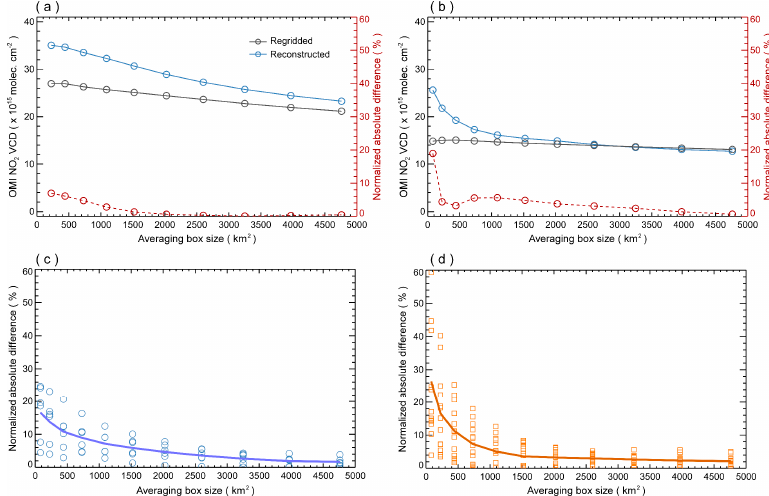
Figure 10. A comparison of the re-gridded and reconstructed OMI NO 2 VCD in terms of an averaging box size for (a) Seoul metropolitan area and (b) a site with cement industrial facilities in South Korea. The normalized absolute difference of the reconstructed OMI NO 2 VCD is given for (c) 6 urbanized area sources and (d) 13 isolated point sources. Solid lines in (c) and (d) represent the mean normalized absolute difference for the urbanized area sources and the isolated point sources. The smoothing effect of the original OMI NO 2 product in quantifying the atmospheric NO 2 column enhancements for the 6 urbanized area and the 13 isolated point sources over South Korea